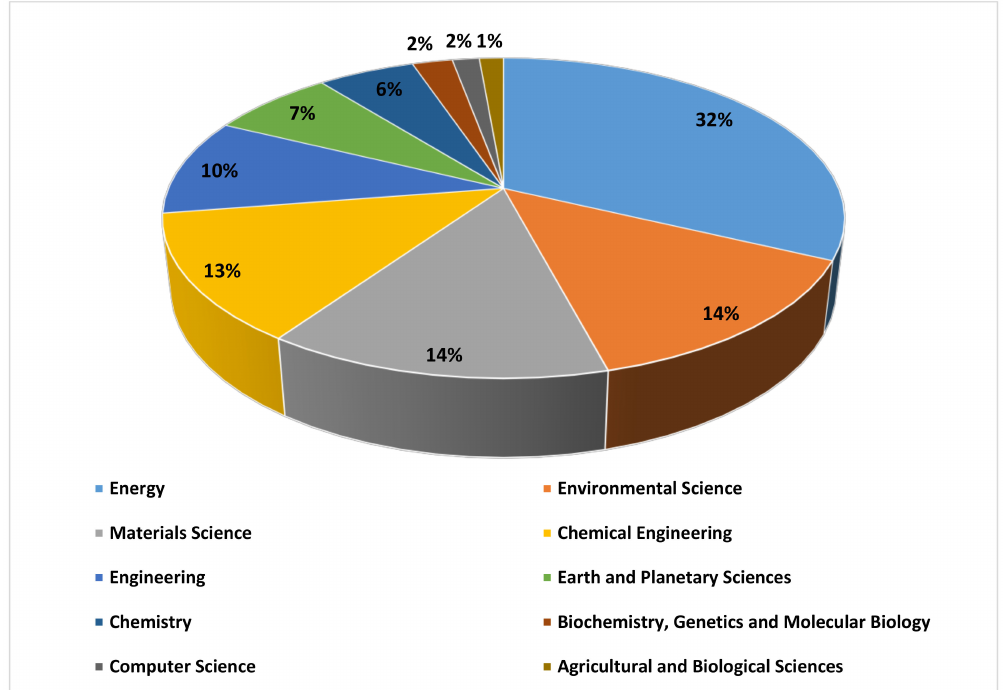
Figure 5. Pie chart showing the percentage distribution of the articles focused on CCU according to subject